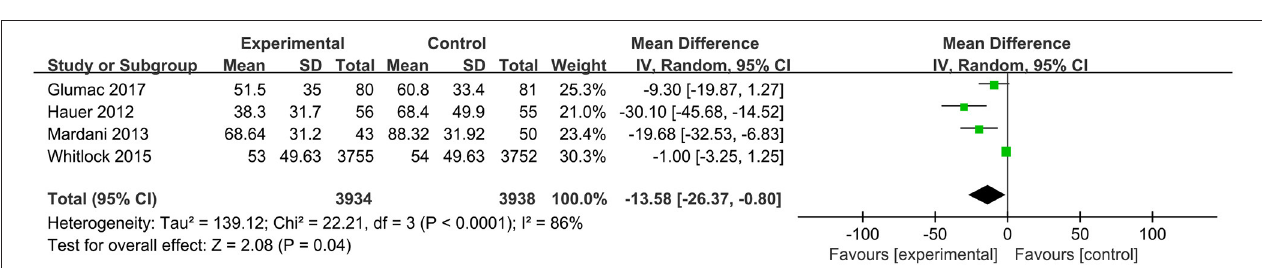
FIGURE 7 | Forest plot of length of ICU